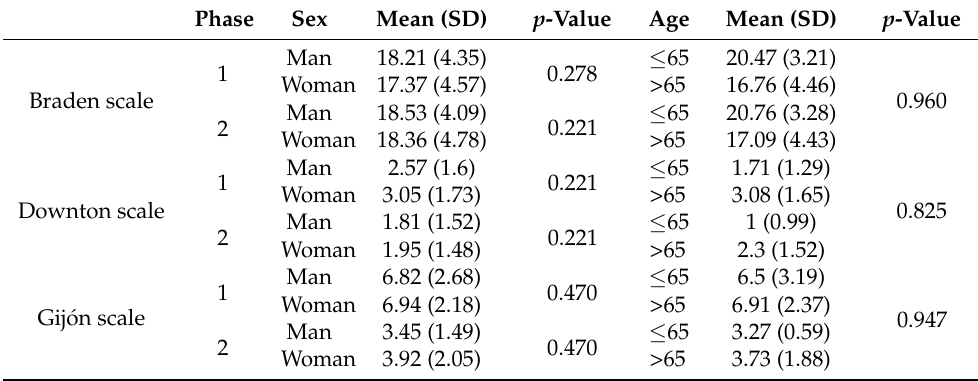
Table 4. Analyses of risk scale scores for age group and